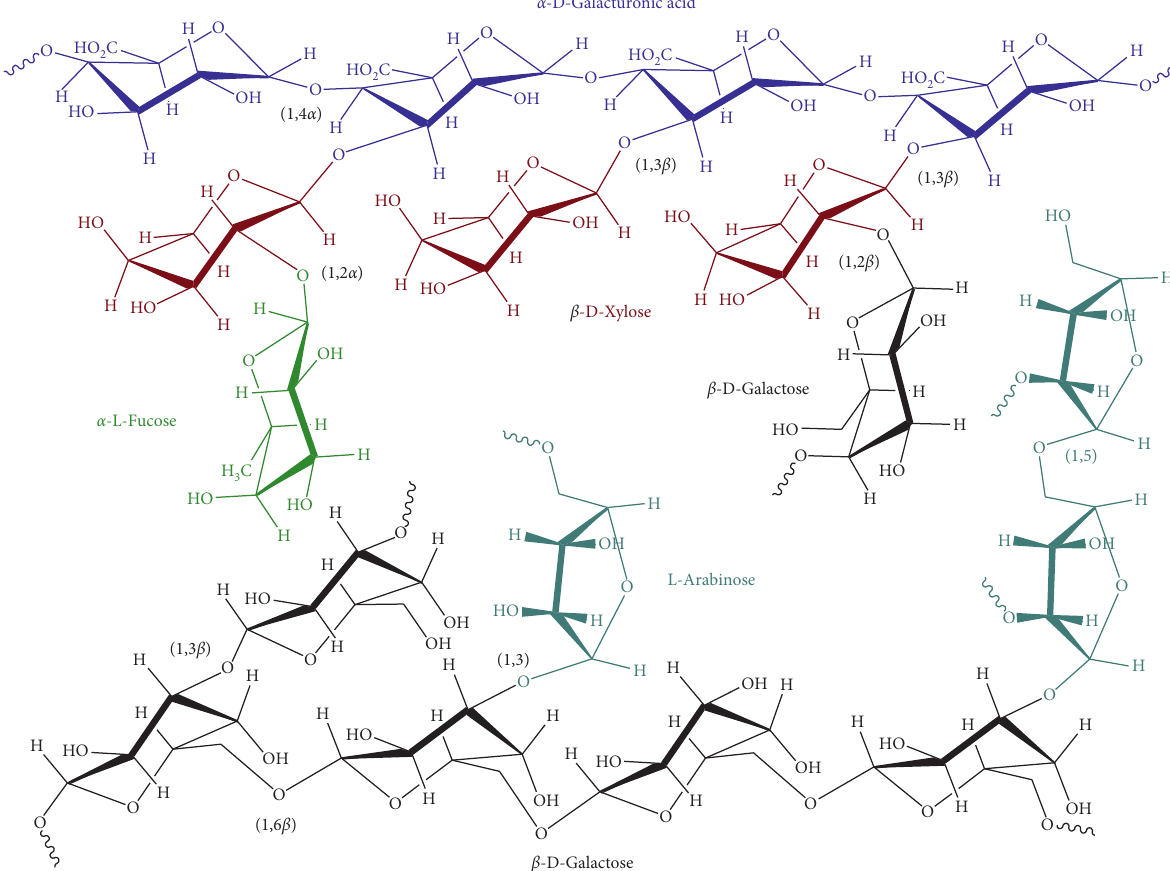
Figure 1: Chemical structure of TG, adapted from